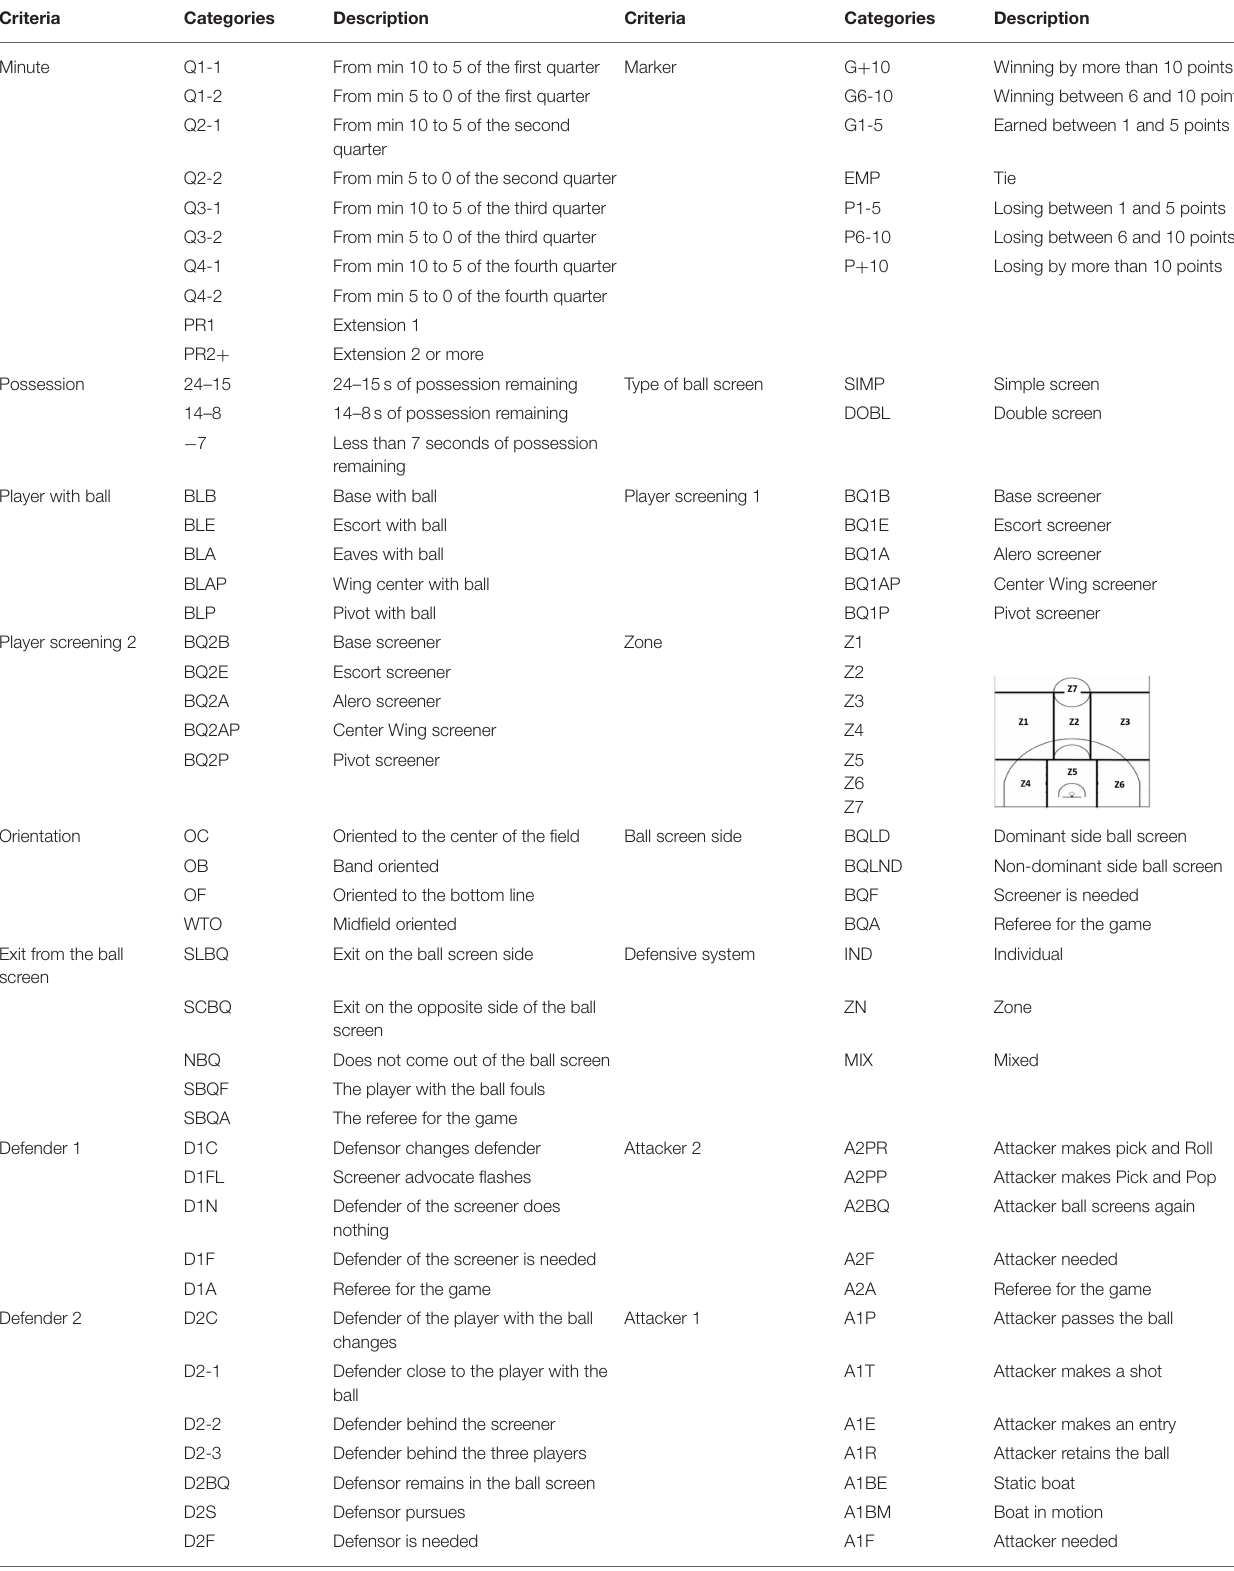
TABLE 1 | Observation instrument for the tactical assessment of ball screen in basketball (VTBDB).